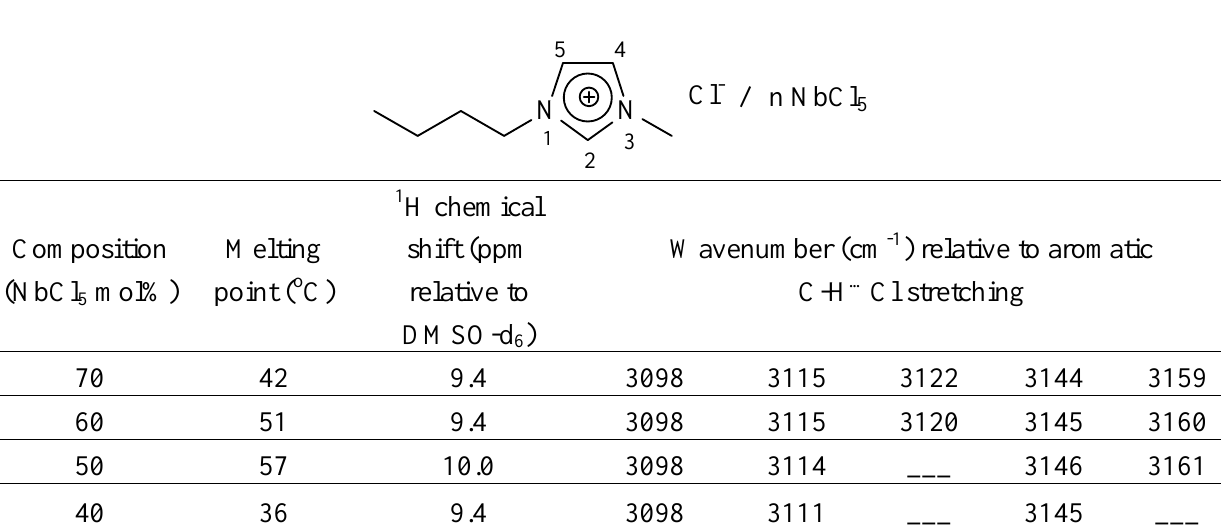
Table 1 . Some spectroscopic and physical-chemical properties of 1-butyl-3-methyl-imidazolium chloride/ niobium pentachloride ionic